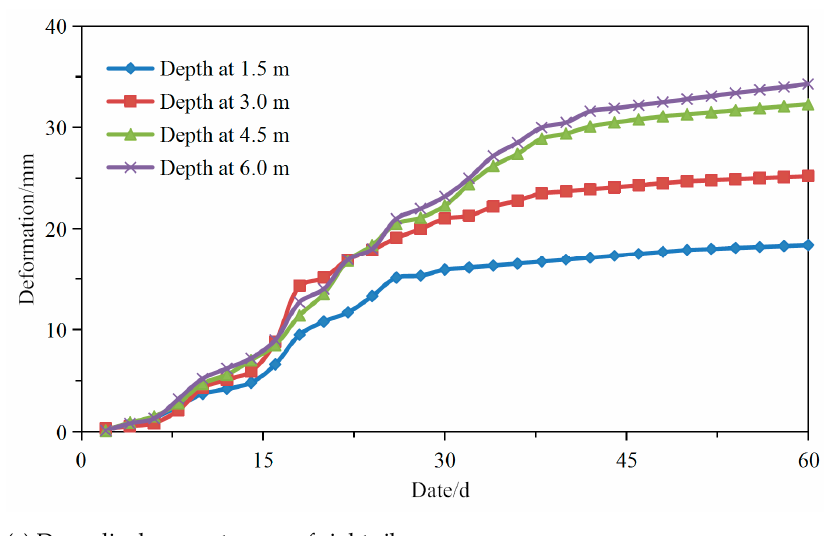
Figure 14. Displacement curve of the deep surrounding rock in the section roadway. The curve of the displacement observation of the surrounding rock surface is shown in Figure 15.